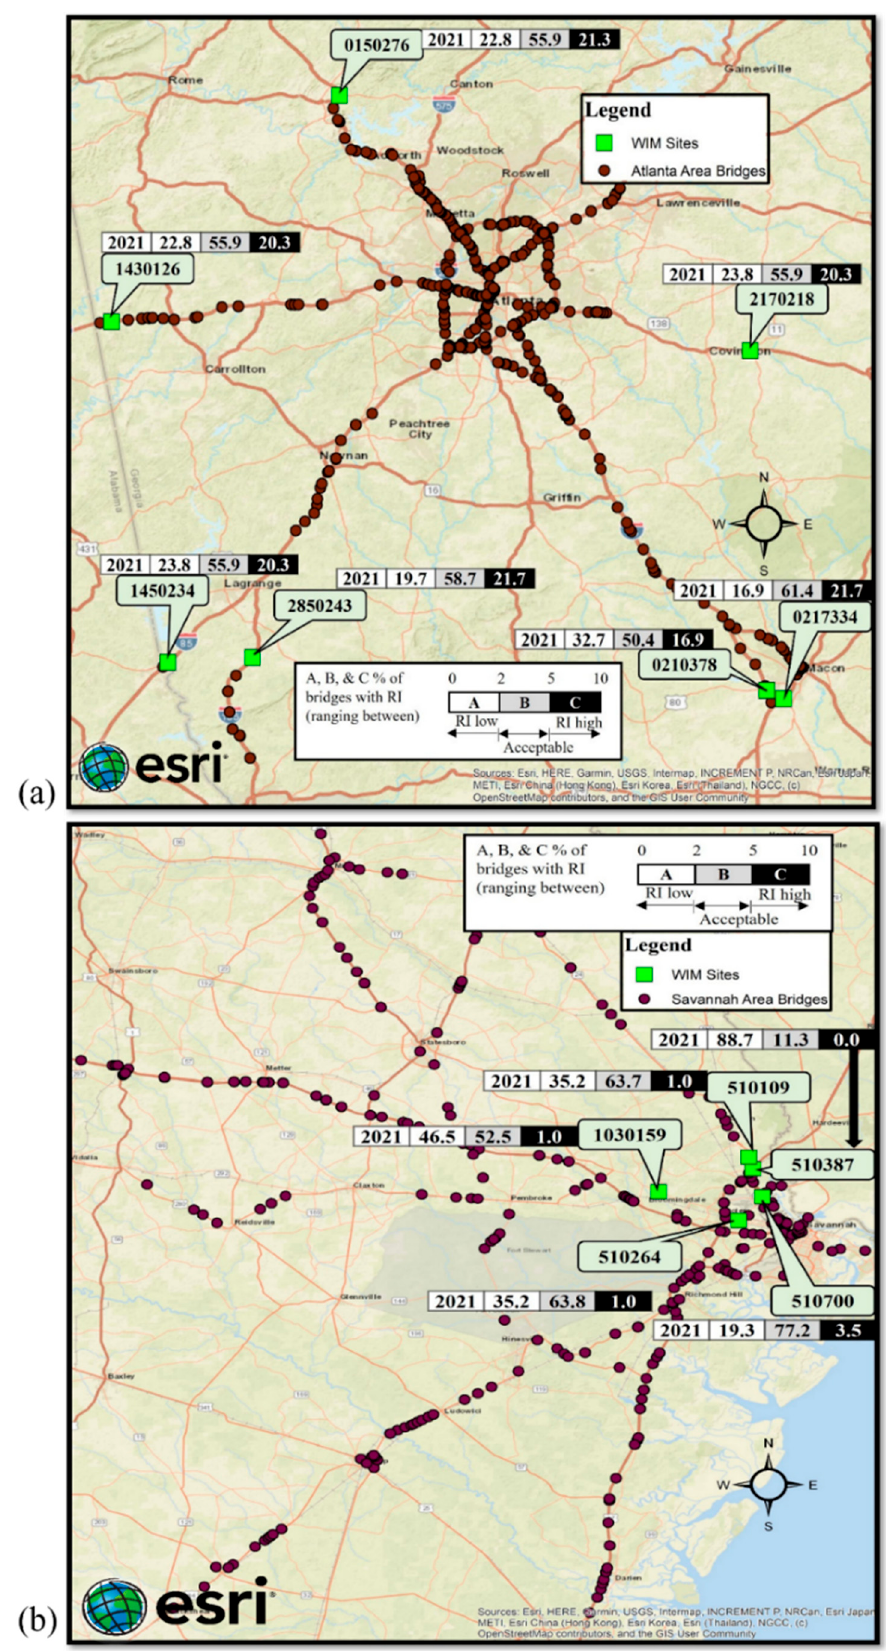
Figure 10. Reliability indices of bridges in the ( a ) Atlanta and ( b ) Savanah areas.